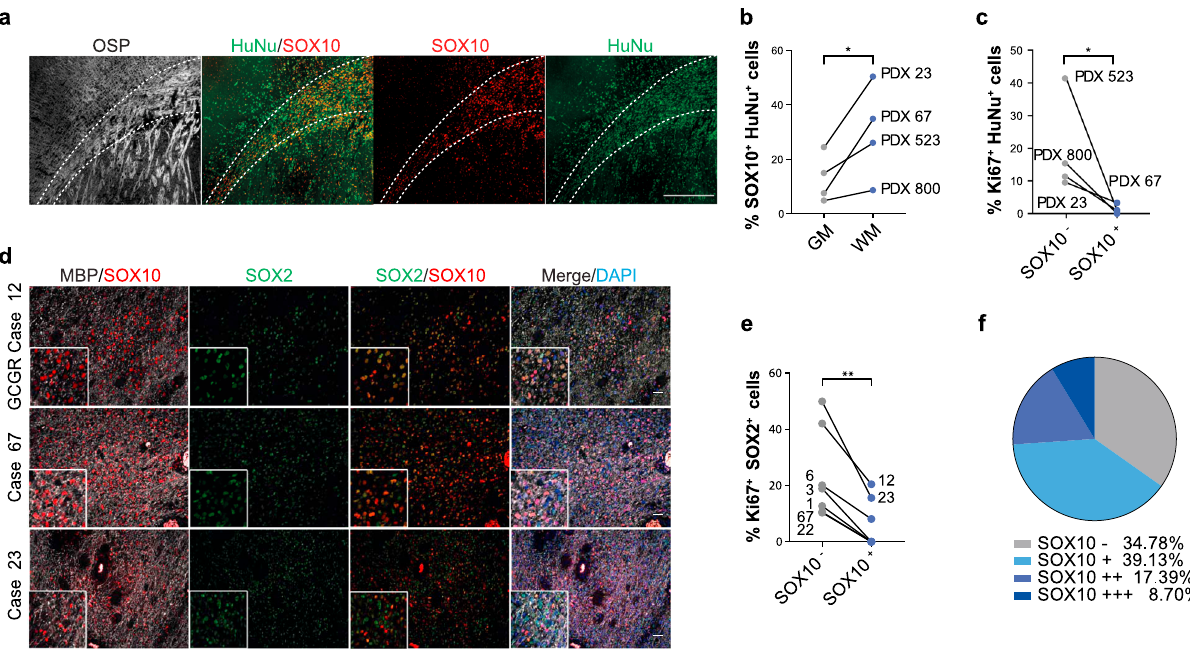
Fig. 2 Differentiation in white matter is a general GBM response. a representative immuno fl uorescence image of a SOX10 + patient-derived xenograft (PDX 23) stained for SOX10 (red), oligodendrocyte-speci fi c protein (OSP, grey) and human-speci fi c nuclear antigen (HuNu, green) to label all tumour cells. Scale = 500 µ m. b quanti fi cation of percentage of SOX10 + /HuNu + tumour cells in white and grey matter of indicated patient-derived xenografts. n = 4 independent xenograft models. For each xenograft, ≥ 550 cells were quanti fi ed across 2 independent ROIs selected within white or grey matter. p = 0.05, Mean, paired one-tailed Student ’ s t test. c quanti fi cation of percentage of proliferating SOX10 + and SOX10 − tumour cells in the corpus callosum of indicated xenografts. For each xenograft, ≥ 500 SOX10 + or SOX10 − cells were quanti fi ed across 2 independent ROIs, n = 4 independent xenograft models. p = 0.05, Mean, paired one-tailed Student ’ s t-test. d MBP (grey) and SOX10 (red) immuno fl uorescence staining of white matter regions of patient tumours. SOX2 (green) was used to identify tumour cells and distinguish them from resident glia. Cases shown are the original tumours from which lines GL23, GL67 and GCGR L12 used in this study have been isolated. Inset shows a close-up of the same image. Scale = 50 µ m. e quanti fi cation of percentage of SOX2 + /SOX10 + and SOX2 + /SOX10 − tumour cells undergoing proliferation (Ki67 + ) in patient tumours. For each case, ≥ 300 cells were quanti fi ed across 2 independent ROIs, n = 7 cases. P = 0.002, Mean, paired one-tailed Student ’ s t-test. f pie chart representation of SOX10 expression in 23